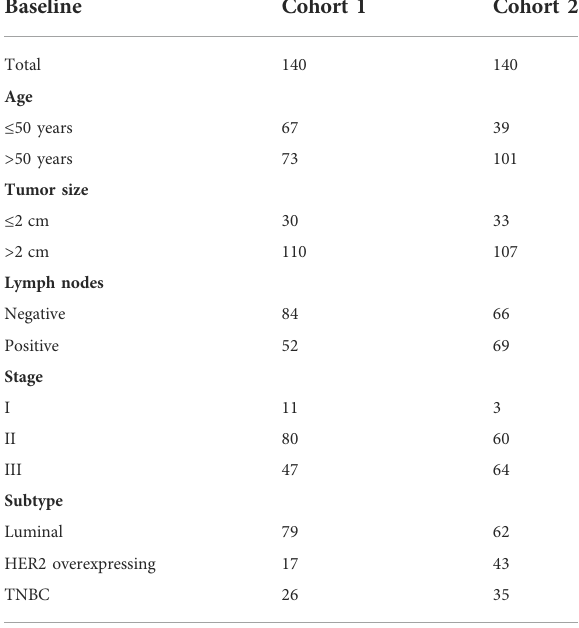
TABLE 1 Baseline of all